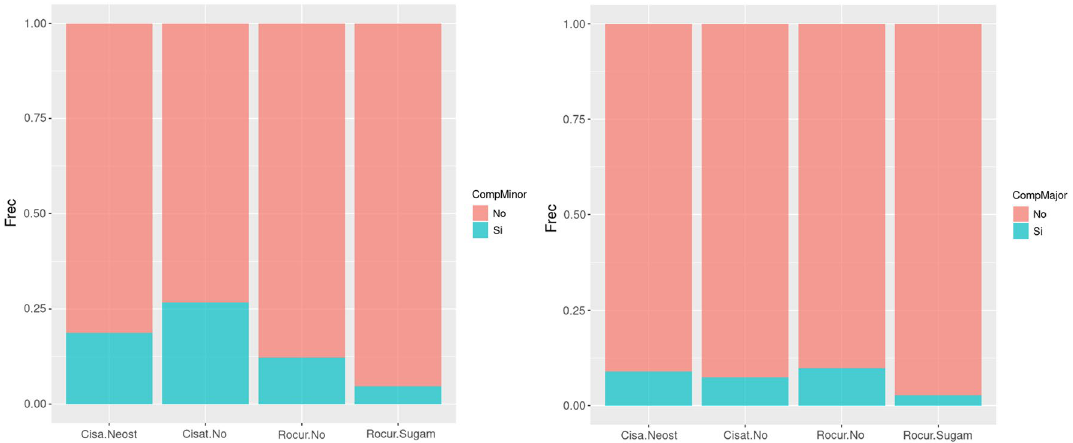
Figure 2. Comparison of late-onset postoperative pulmonary complications (pneumonia and atelectasis) if exits early postoperative pulmonary complications (hypoxemia and airway obstruction). CompMinor early postoperative pulmonary complications, CompMajor late-onset postoperative pulmonary complications.